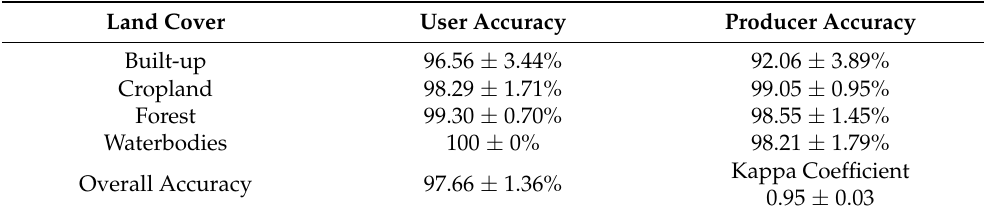
Table 3. Accuracy of the LULC classification results for 2000–2020.